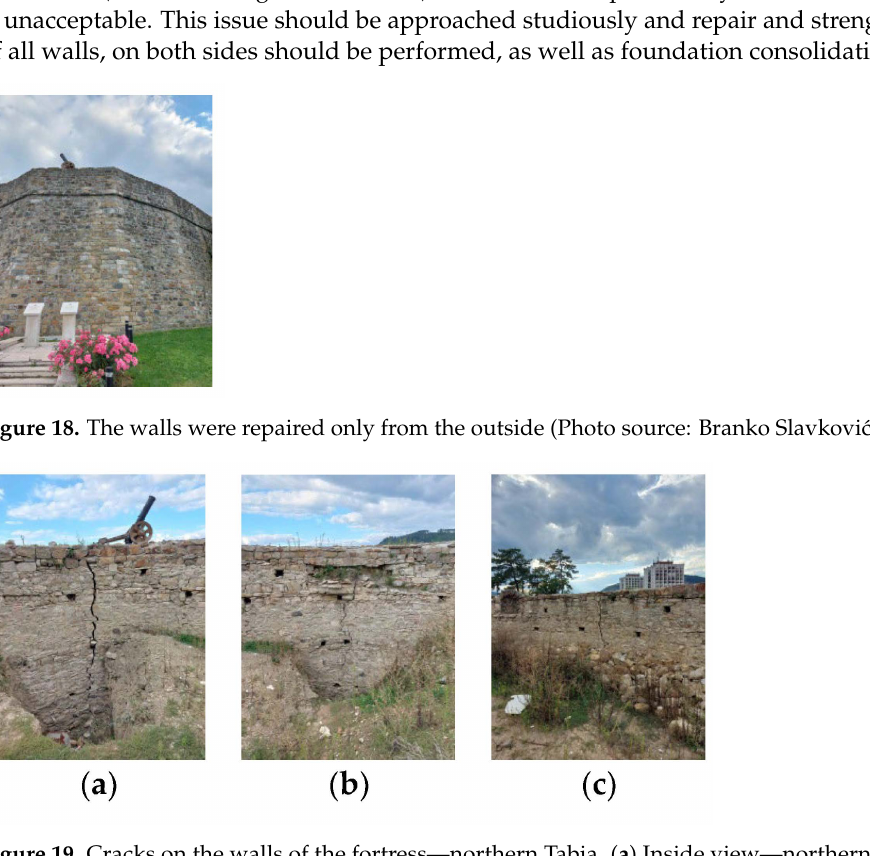
Figure 19. Cracks on the walls of the fortress—northern Tabia. ( a ) Inside view—northern position; ( b ) inside view—eastern position; ( c ) inside view—western position (Photo source: Branko